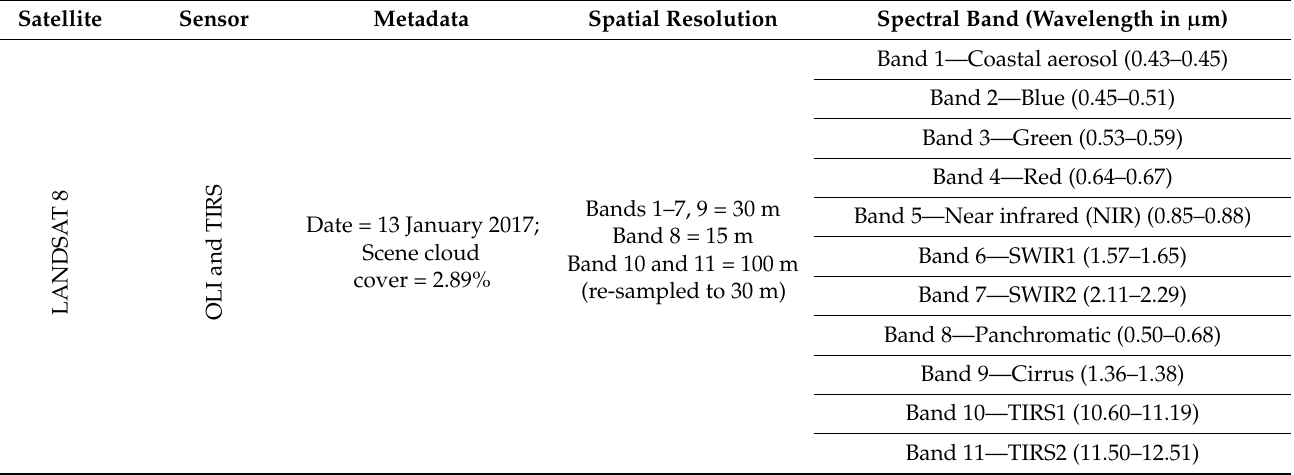
Table A4 provides details of the satellite image (Operational Land Imager—OLI, and thermal infrared sensors—TIRS) used for the study. Table A4. Detail information of the image used for the